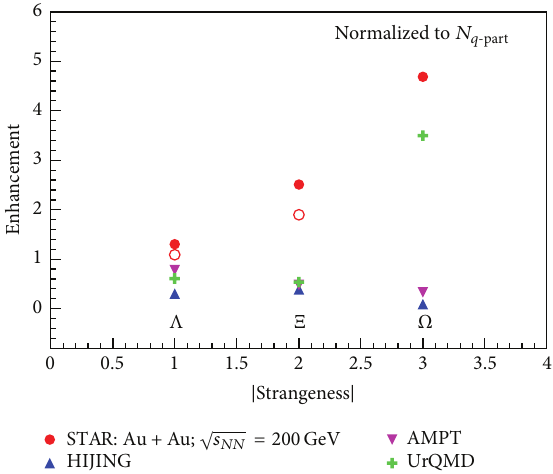
Figure 11: Midrapidity 𝑁 𝑞 -normalized enhancement of multi- -part strange baryons as a function of strangeness content for Au + Au collisions at √𝑠 𝑁𝑁 = 200 GeV at RHIC. The filled and open circles are for the particles and anti-particles, respectively.